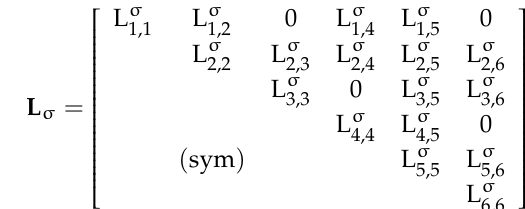
( , ) A x y and magnetic field ( , ) H x y in the air window obtained from FEM and the DPDO.